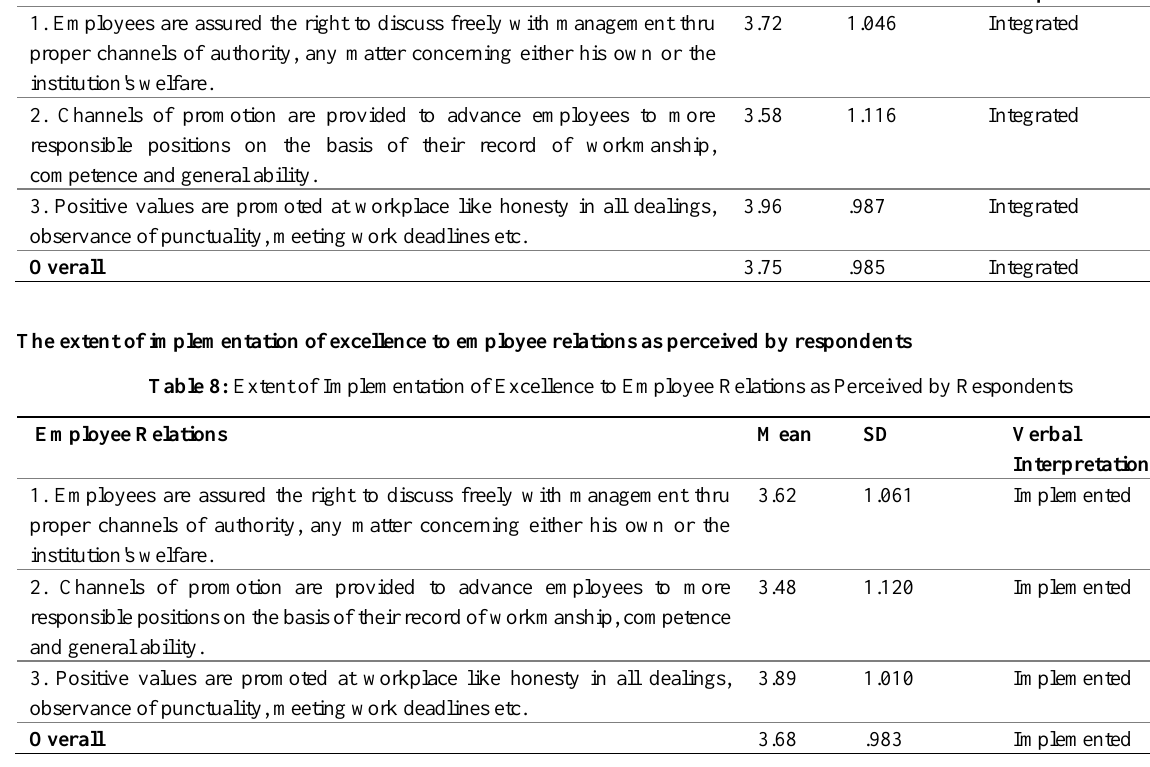
Table 7: Extent of Integration of Excellence to Employee Relations as Perceived by Respondents Employee Relations